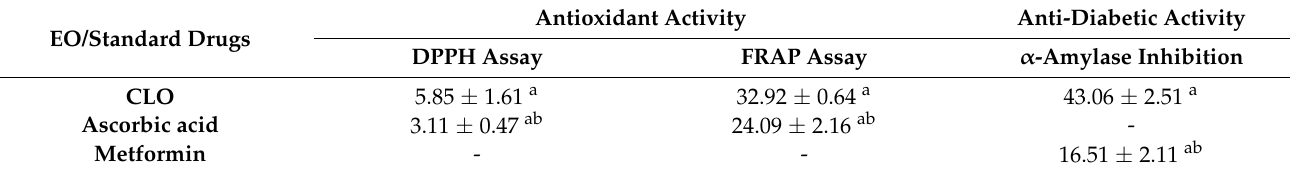
Figure 2. Dose-dependent antioxidant and anti-diabetic activity shown by CLO. ( A ) % DPPH radical scavenging method; ( B ) FRAP method; ( C ) α -amylase inhibition assay. Ascorbic acid and metformin were used as standard controls in antioxidant and anti-diabetic assays. The experiments were repeated thrice, and values are expressed as mean ± S.D. (n = 3). Table 3. Half maximal inhibitory concentration (IC 50 ) of CLO, ascorbic acid, and metformin in terms of antioxidant assay and anti-diabetic assay. DPPH and α -amylase inhibition activity were calculated in terms of µ g/mL, while FRAP activity was calculated in terms of µ M Fe (II) equivalents. The lower the value of IC 50 , the higher the antioxidant/anti-diabetic